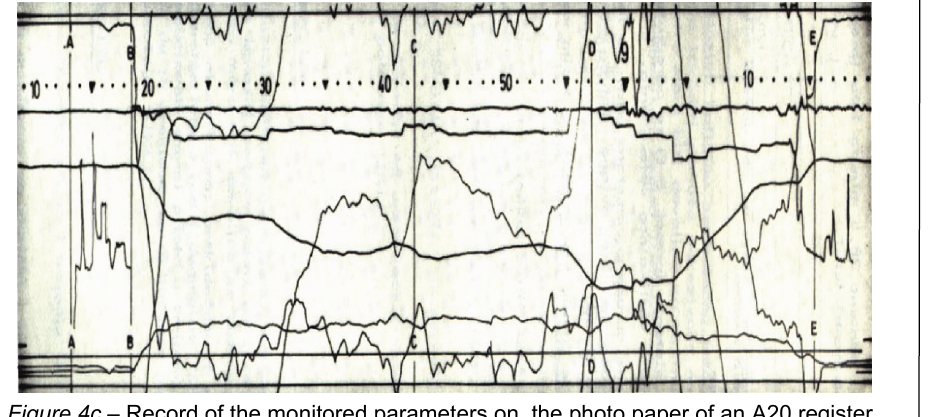
Figure 4c – Record of the monitored parameters on the photo paper of an A20 register during the tests (Arhiv Vazduhoplovnog opitnog centra,